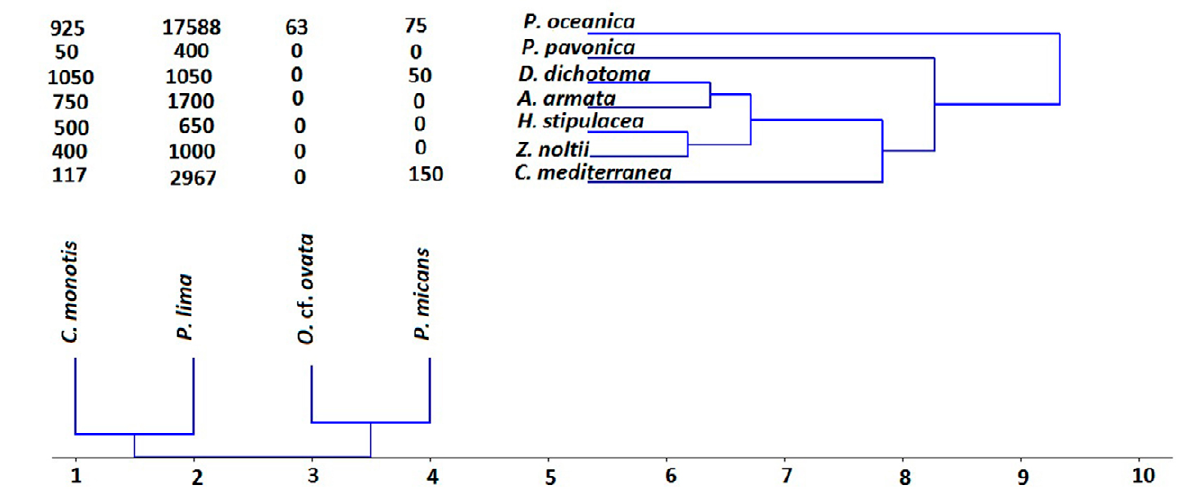
Fig. 4. – Degree of similarity between the different substrates in terms of spring average concentration of toxic dinoflagellates on each substrate.